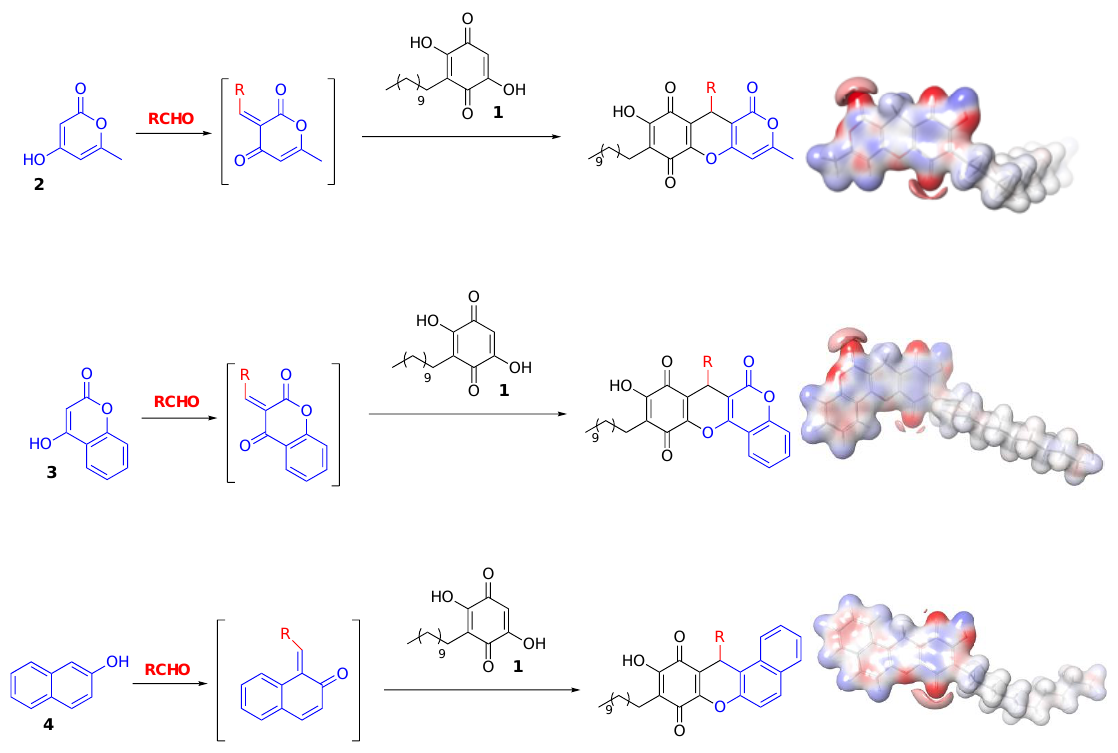
Table 1. Optimization of the MCR of 1 , 2 and 4-bromobenzaldehyde